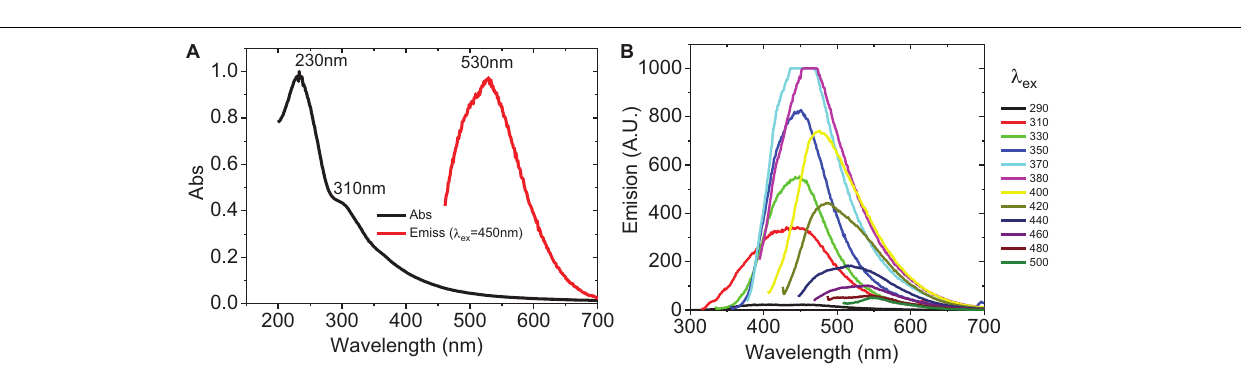
FIGURE 3 | Characterization of C-DOTS. (A) FTIR spectrum of C-DOTS. (B) XRD pattern for the C-DOTS. (C) Raman spectrum of C-DOTS.